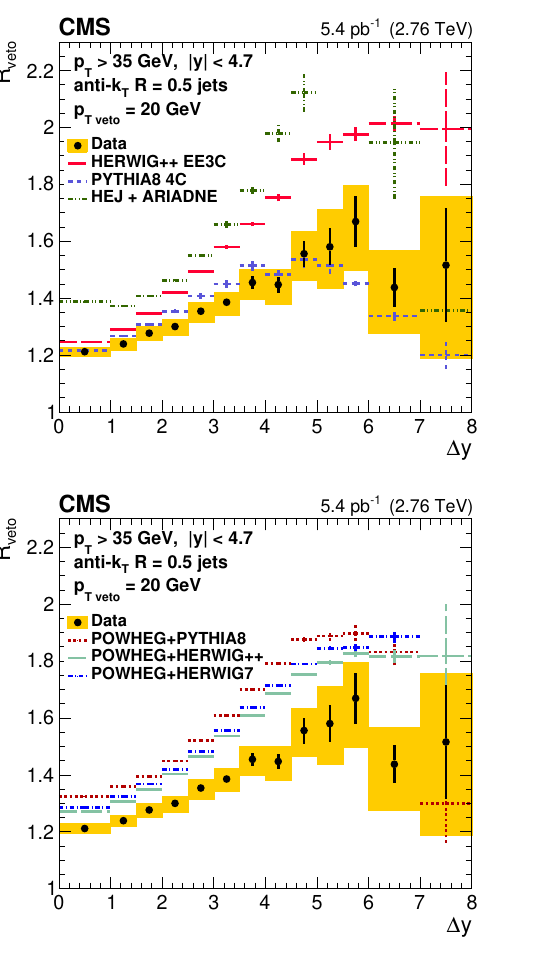
of the cross sections for MN to “exclusive” with veto dijet production. The Figure 7 . Ratio R MN veto upper and lower rows present the comparison with different MC models. The plots on the left present the ratio R MN and those on the right the ratio of theory to data. The systematic uncertainties are veto indicated by the shaded bands and the statistical uncertainties by the vertical